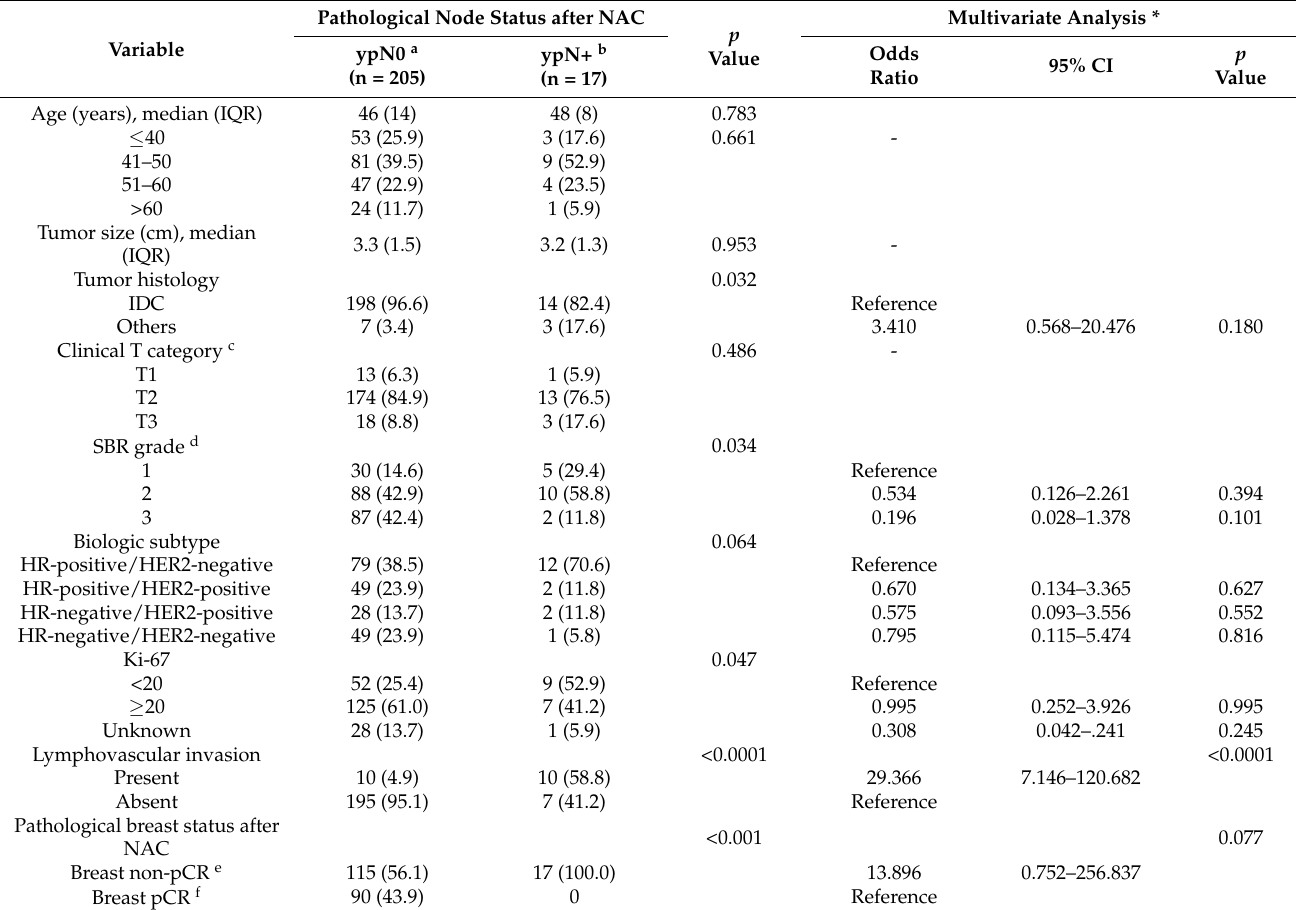
Table 2. Univariate and multivariate analysis of factors influencing the lymph node status in the whole patient cohort after